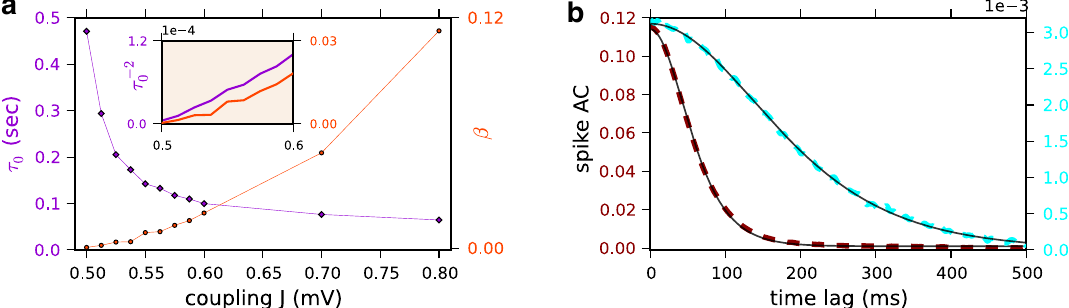
Figure S1. ( a ) The decorrelation time ( τ , violet diamond, left y-axis) and amplitude at zero time lag (beta, orange circles, right y-axis) of the 0 baseline-subtracted population averaged spike AC are plotted vs. J for the Poisson network. These parameters were obtained by fitting the - 2 (left axis, violet) and β values (orange, right axis) spike AC with ACF ( τ ) = β /cosh ( τ / τ ) 2 (see Figure S1b). Inset: the rescaled estimated τ 0 0 for J=0.5, 0.5125, 0.525, 0.5375, 0.55, 0.5625, 0.575, 0.5875 and 0.6 mV, to show that they vanish linearly near the phase transition. ( b ) The non-normalized spike AC can be very well fitted by ACF ( τ ) = β /cosh ( τ / τ ) 2 . Dashed lines: Simulation results; J=0.525 mV (cyan, right y-axis) 0 and J=0.8 mV (dark red, left y-axis): Black solid line: The